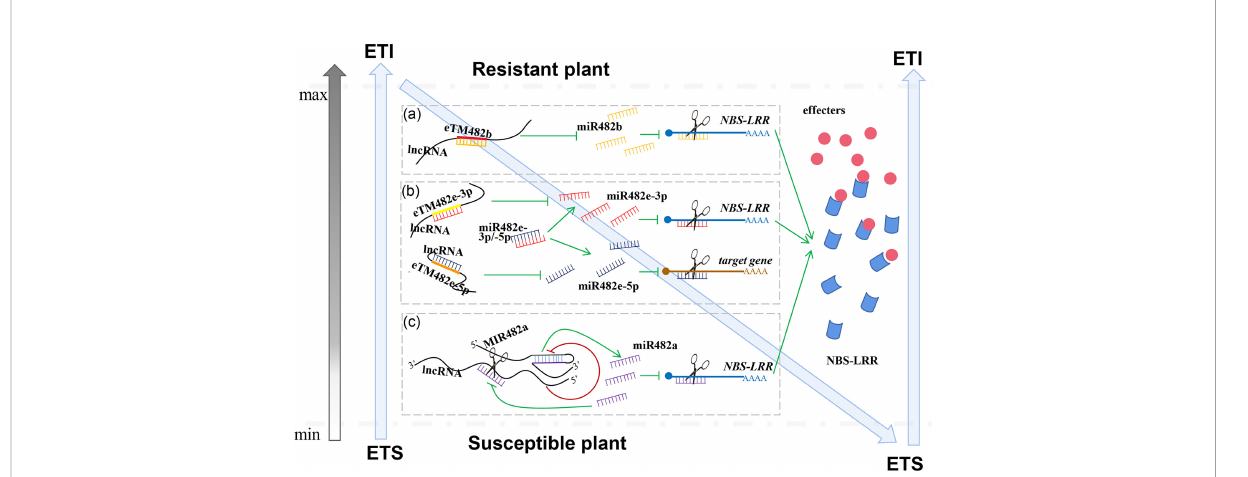
FIGURE 2 miR482/2118 and lncRNAs are important components in the effector-triggered immunity (ETI) for the plant immune response. In this extended model, lncRNAs function as ceRNAs to modulate resistant genes by decoying miR482b-3p (A) , miR482e-3p and -5p (B) in ETI for the plant innate immune response. Other lncRNAs as NATs suppress the levels of pre-miR482a to affect the expression of mature miR482a, which leads to accumulation of resistant genes, NBS-LRRs is increased (C) . When excessive amounts of resistant genes accumulate, mature miR482a cleaves NATs to relieve the suppression of pre-miR482a, leading to an increase in accumulation of mature miR482a and decreased accumulation of resistant genes, thus maintaining resistant genes